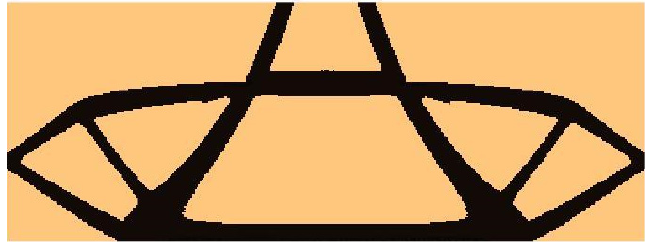
Figure 10. The final topology found for the test structure 1.